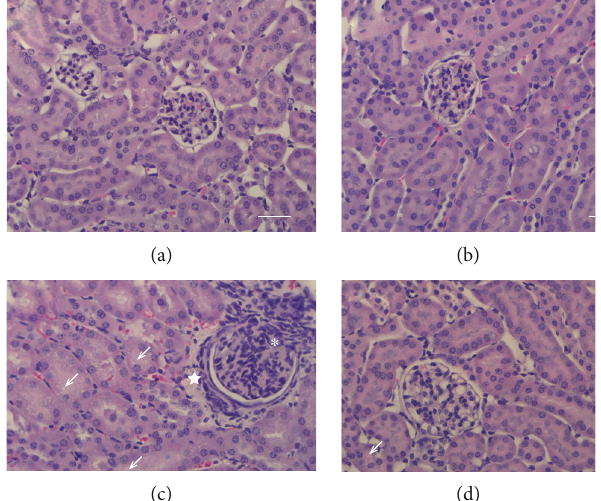
Figure 2: Representative histology photomicrographs of mice kidney stained with hematoxylin and eosin. Sham (a), sham + simvastatin (b), CLP (c), and CLP+ simvastatin (d). Tubular vacuolization (arrow), glomerular cell proliferation (asterisk), increased peri-capsular stroma (star). Bar 50 μ